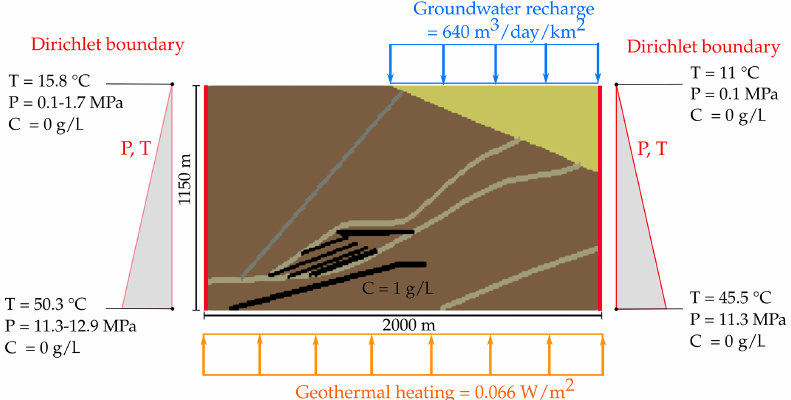
Figure 3. Initial and boundary conditions of the thermo-hydrogeological model. Differences in model topography are represented by the increased p/T conditions at the left model